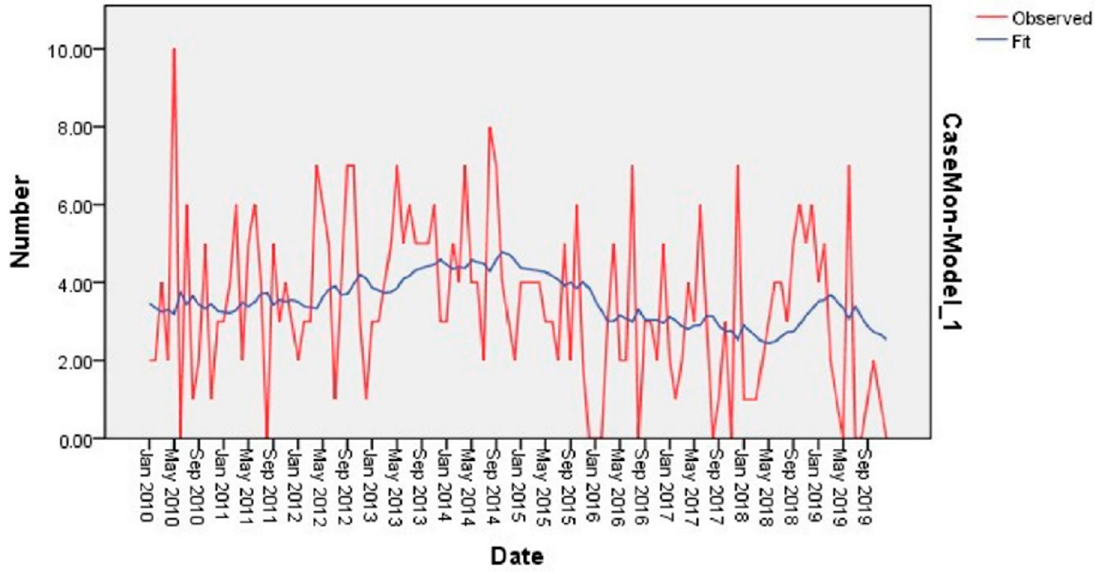
ten years ( p = 0.738). The mean temperatures per year in Belgrade, Serbia, between the Figure 1. Rates of stillbirths per month during the examined ten years (2010–2019). years 2010 and 2019 are presented in Figure 2. Figure 1. Rates of stillbirths per month during the examined ten years (2010-2019).